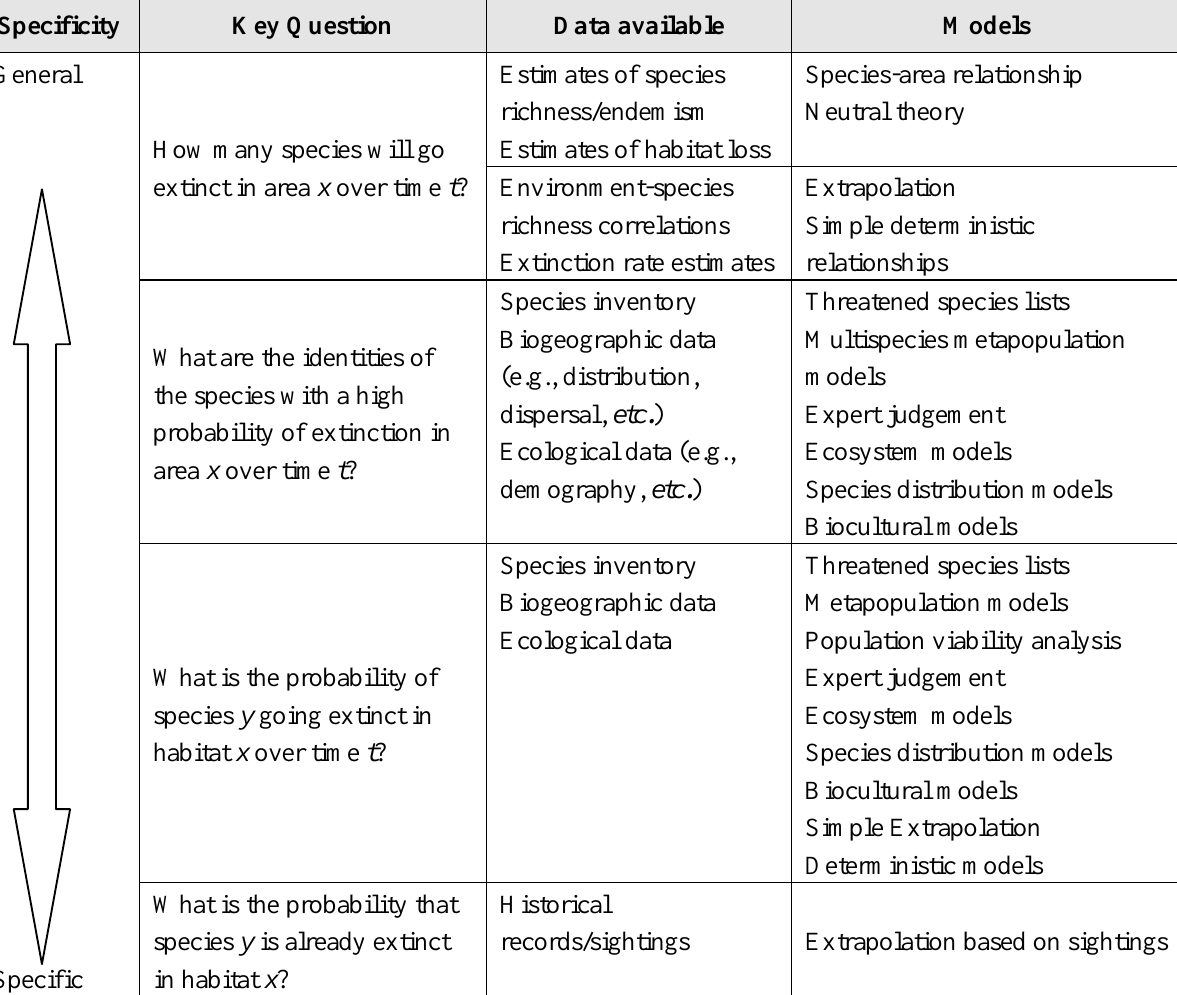
Table 1. A use-based framework for classifying extinction forecasting models based on the four fundamental questions about extinction (see text for full explanation). Model choice is critically constrained by type of data available. Specificity refers to taxonomic level (individual species versus extinctions within a defined area) and geographical